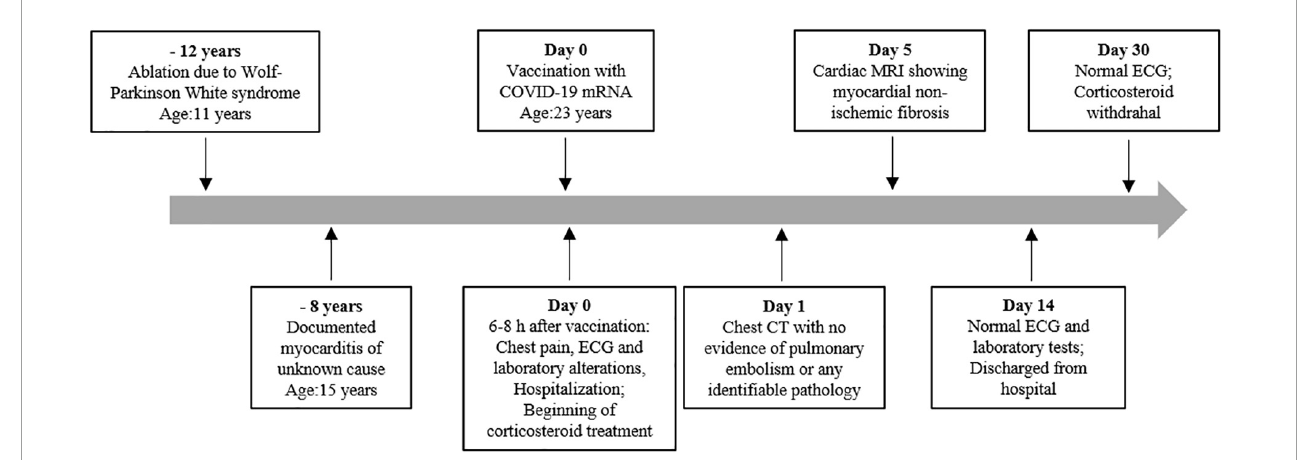
FIGURE3 Timeline of the patient’s previous cardiac diseases, myocarditis, and pericarditis post-BNT162b2 messenger RNA (mRNA) (Pfizer-BioNTech) vaccine.